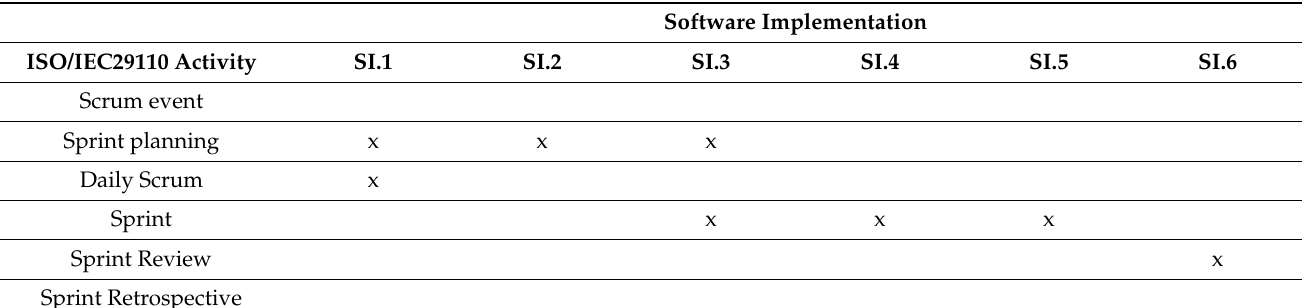
Table 6. The mapping of activities in the software implementation (SI) process and Scrum events.